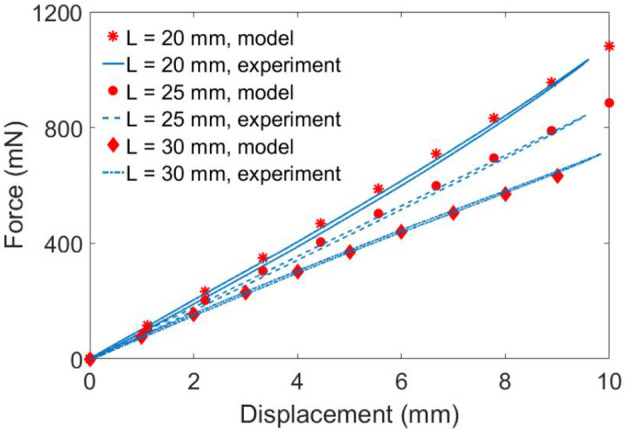
Passive quasi-static experimental results and model predictions. L = 20, 25, 30 mm.